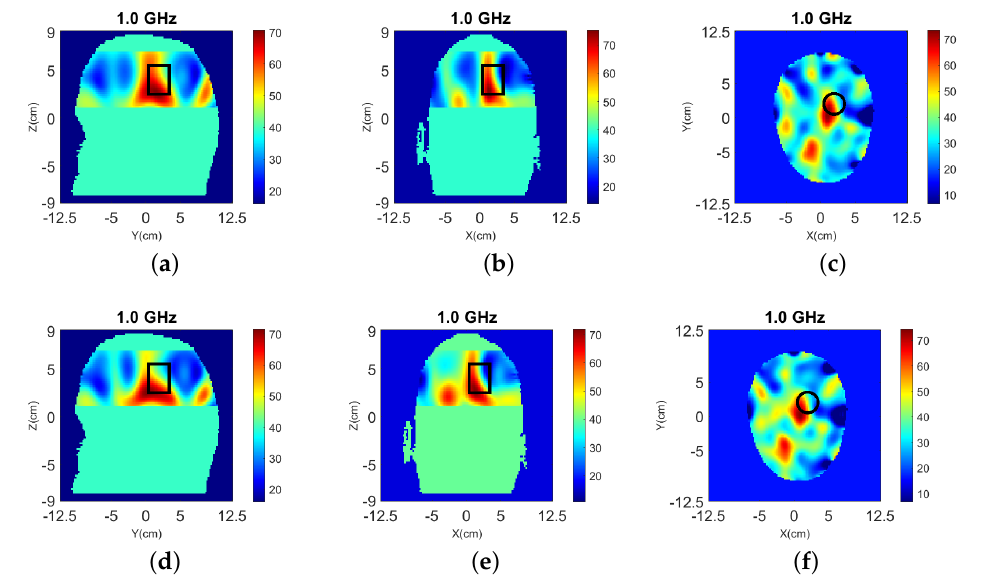
Figure 12. 3-D reconstructions of (cid:60) ( ε r ) at 1.0 GHz: ( a ) y-z slice, ( b ) x-z slice, and ( c ) x-y slice for Case II.1; ( d ) y-z slice, ( e ) x-z slice, and ( f ) x-y slice for Case